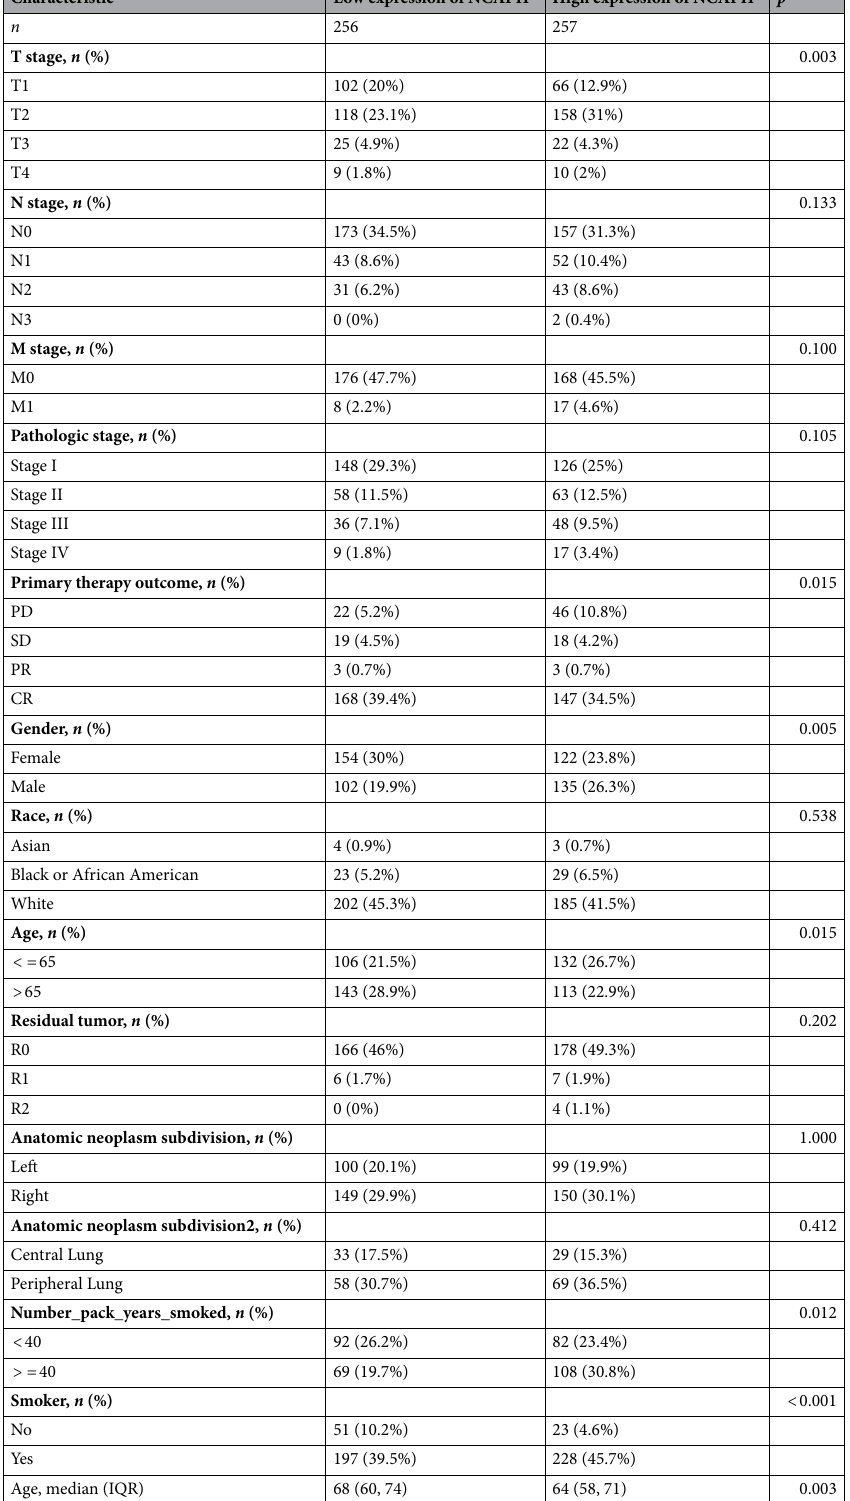
Table 1. The correlation between clinicopathological variables and NCAPH